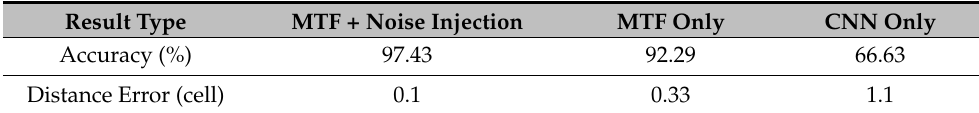
Table 2. Results of position accuracy and distance error on our model for the “MTF only” and “CNN only” methods.